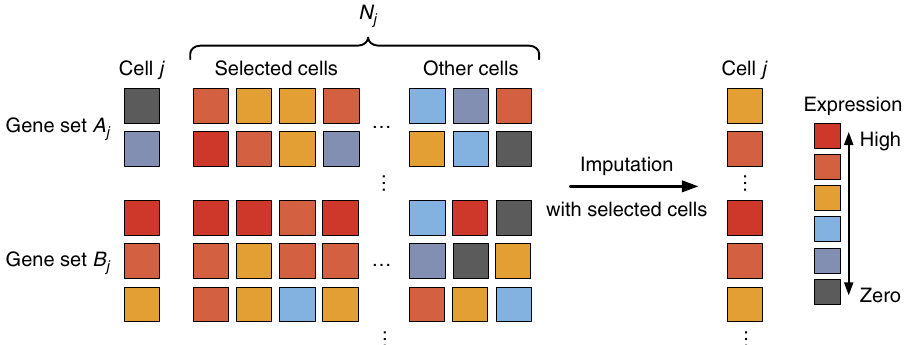
Fig. 1 A toy example illustrating the work fl ow in the imputation step of scImpute method. scImpute fi rst learns each gene ’ s dropout probability in each cell by fi tting a mixture model. Next, scImpute imputes the (highly probable) dropout values in cell j (gene set A j ) by borrowing information of the same gene in other similar cells, which are selected based on gene set B j (not severely affected by dropout events). The details are described in Eqs. (2) and